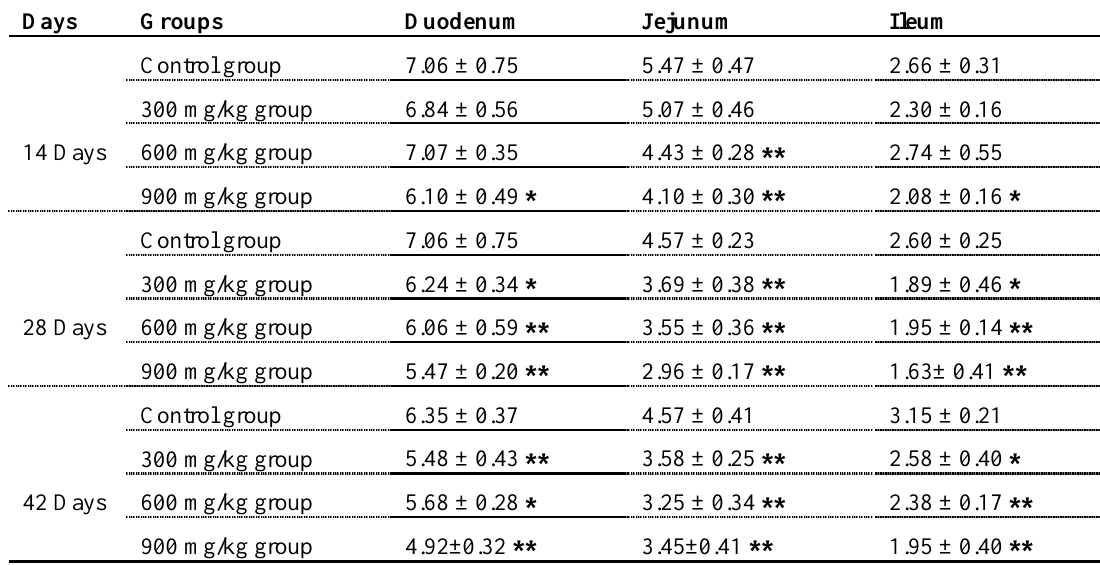
Table 5. Change of the GSH content (mg/gprot) in the intestinal